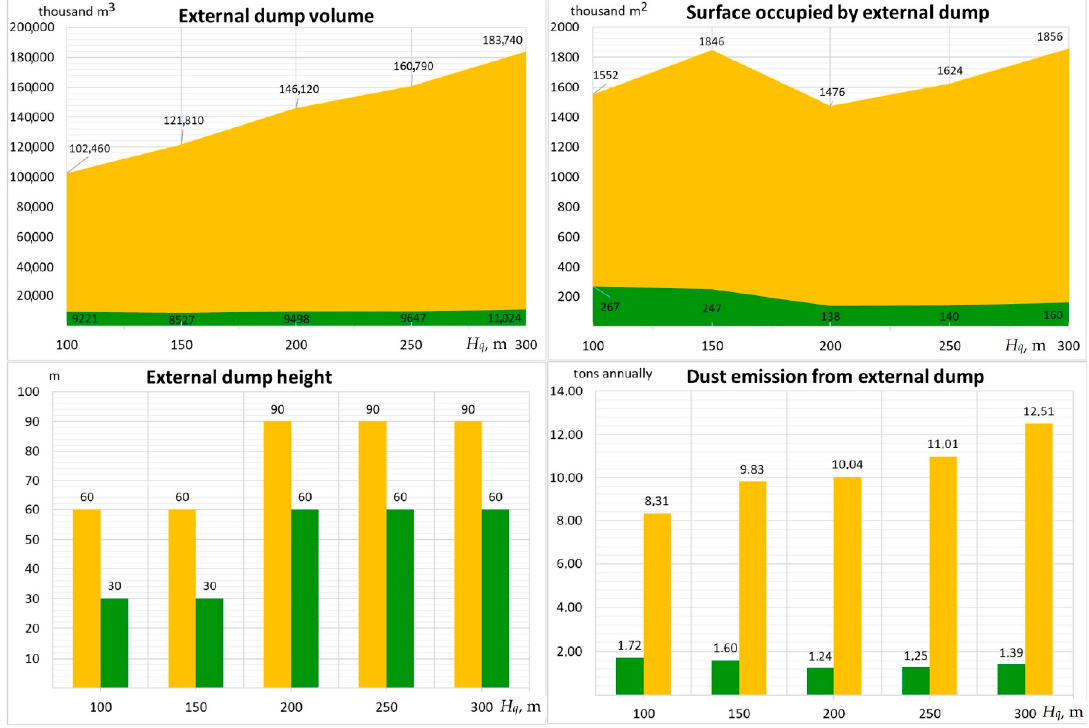
Figure 11. Comparison of the external dumping parameters and its influence on the environment for deepening longitudinal and continuous lateral mining deepening longitudinal and continuous lateral mining methods.